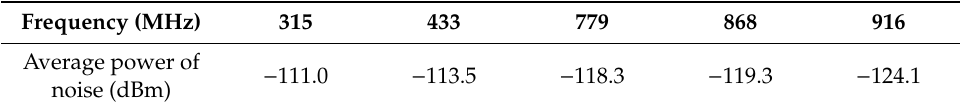
Figure 5. Spectrums of noises measured at five frequency bands. ( a ) Amplitude spectrum of noise at 315 MHz; ( b ) Amplitude spectrum of noise at 433 MHz; ( c ) Amplitude spectrum of noise at 779 MHz; ( d ) Amplitude spectrum of noise at 868 MHz; ( e ) Amplitude spectrum of noise at 916 MHz; ( f ) Amplitude spectrum of noise at 916 MHz. Table 4. Average power at di ff erent frequencies.